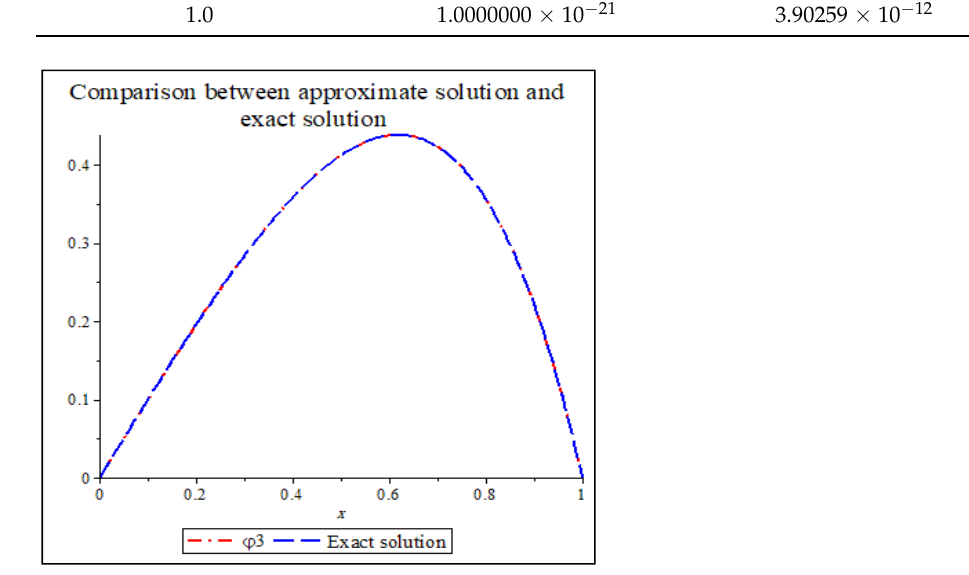
Figure 4. Comparison of the exact solution and the approximate solution of 𝜑 (cid:2871) in Example 4.